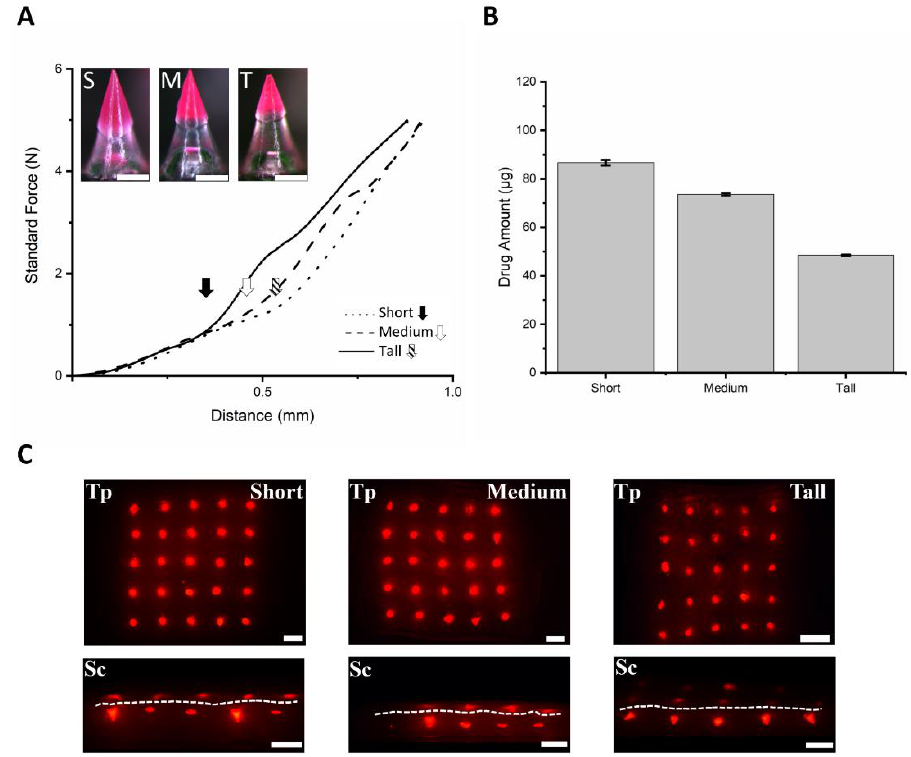
Figure 5. ( A ) Images of dissolving microneedles (DMNs) with three different ratios of polycaprolactone (PCL) and polyvinyl alcohol (PVA) with polyvinylpyrrolidone (PVP) (scale bar: 250 µ m). S, M, and T in the upper left indicate short, medium, and tall, respectively. Each SPCL-DMN was designed with 274.6 ± 5.8, 349.1 ± 5.0, and 412.3 ± 3.8 µ m of base height, respectively ( n = 10, mean ± SEM). The graph illustrates the standard force against press by time. Standard force was recorded by moving the probe across the axial distance; the arrow marks indicate the shift of the slope. ( B ) Amount of capsaicin in PCL based on the length of PCL ( n = 3, mean ± SEM). For determining PCL quantity, 20% ( w / w ) capsaicin was dissolved in PCL at 65 ◦ C. The short, medium, and tall PCLs contained 86.66 ± 1.13, 73.62 ± 0.61, and 48.49 ± 0.30 µ g of PCL, respectively ( n = 3, mean ± SEM). ( C ) Application test of separable PCL-DMN (SPCL-DMN) array on porcine skin; the PCL encapsulated with 20% ( w / w ) capsaicin and 3% ( w / v ) Nile red. Upper left letters indicate top (Tp) and sectional (Sc) views of porcine skin. Top view images reveal that all PCL tips were placed on the skin, and sectional view shows porcine skin after application (scale bar: 1 mm). White dash lines indicate the skin surface.